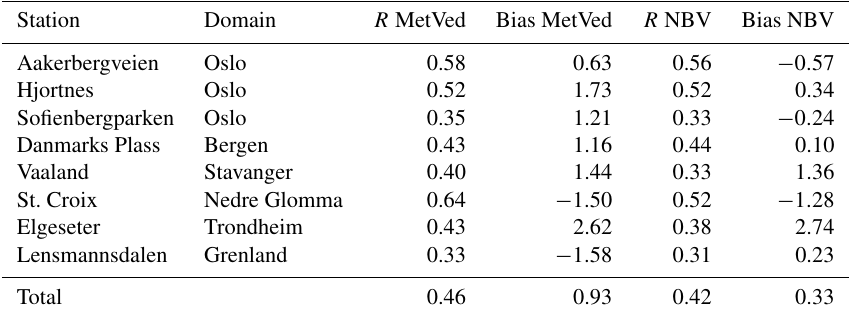
Table 2. The 2015 hourly concentrations fit to observations for EPISODE simulations of PM 2 . 5 for each of the stations. The hourly R is the Pearson correlation coefficient and bias is calculated as model minus observation. Station Domain R MetVed Bias MetVed R NBV Bias NBV